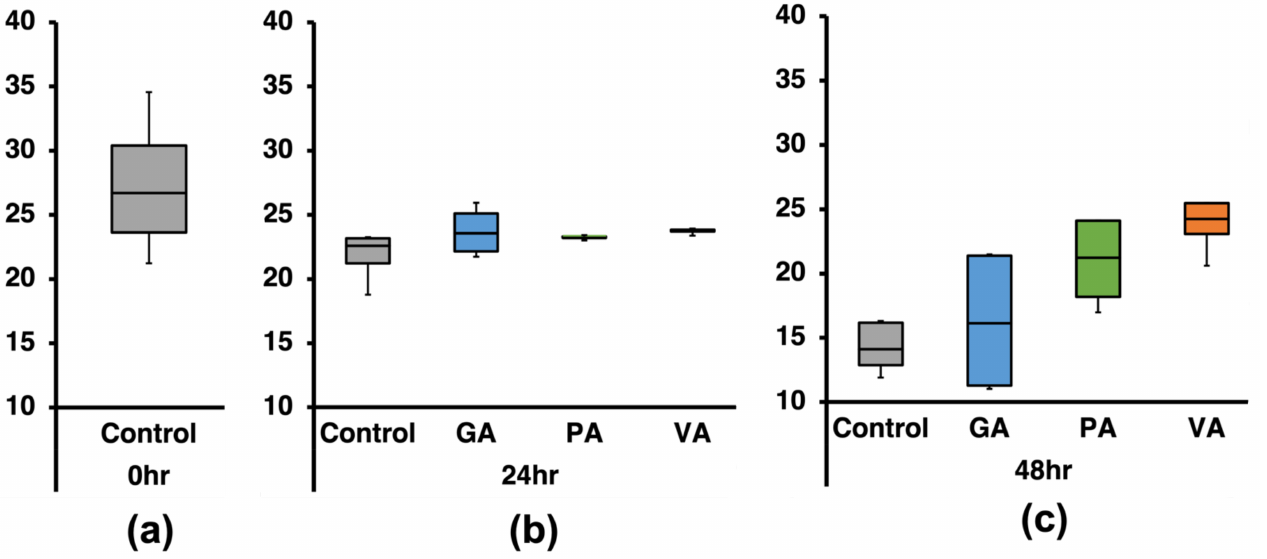
Figure 6. Alpha diversity analysis at the species level using Inverse Simpson Index from 16S-rRNA gene sequencing data at 0 h ( a ), 24 h ( b ), and 48 h ( c ) for determining evenness for an untreated control and groups individually treated with either gallic acid (GA), protocatechuic acid (PA) and vanillic acid